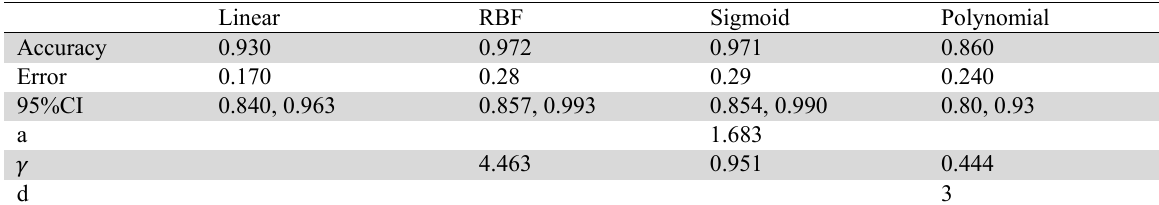
Performance criteria from 2005 to 2006 Linear RBF Sigmoid Polynomial Accuracy 0.930 0.972 0.971